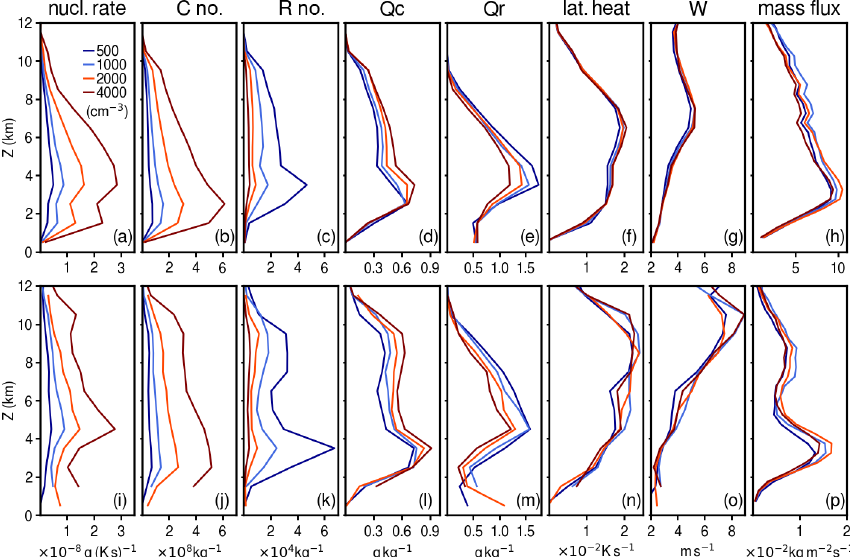
Figure 4. Vertical profiles of the cloud nucleation rate (a, i) , cloud number concentration (b, j) , rain number concentration (c, k) , cloud water mixing ratio (d, l) , rain water mixing ratio (e, m) , latent heating rates (f, n) , vertical velocity (g, o) , and mass flux (h, p) for experiments with different aerosol number concentrations (see the legend in panel a ). Top panels (a–h) are computed from cloudy updraft grid points and lower panels (i–p) from tracked thermals. Note the different scales used for mass flux in panels (h) and (p)